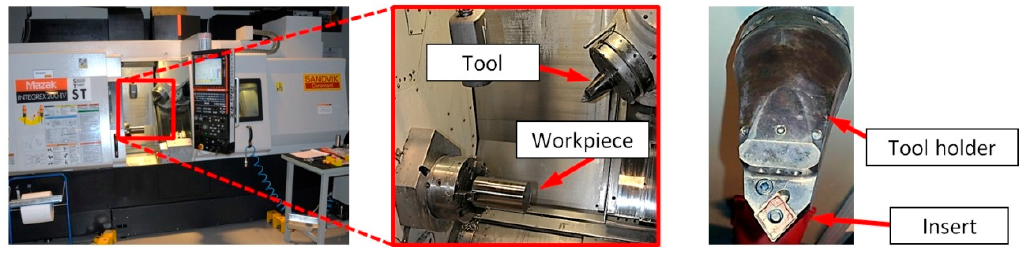
Figure 1. Test stand with the cutting tool.